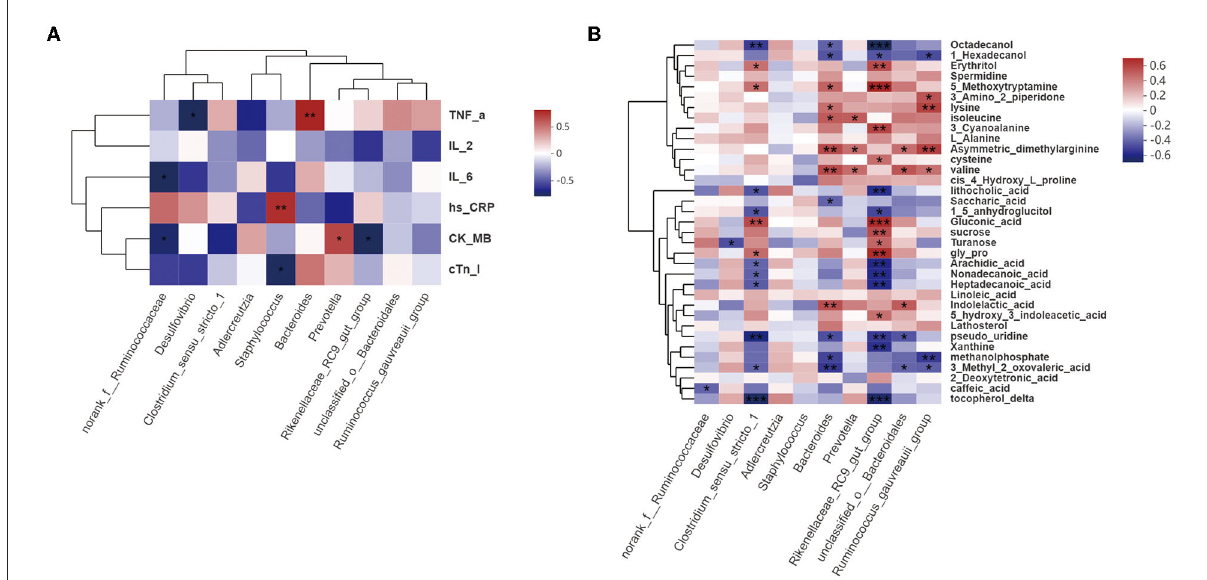
FIGURE8 Correlation analysis. (A) Correlations among gut bacteria, proinflammatory factors (TNF- α , IL-2, IL-6, and hs-CRP), and cardiac function indices (CK-MB and cTnI) (Spearman’s r > 0.1 or < 0.1; n = 6/group). (B) Correlations among gut bacteria and metabolites (Spearman’s r > 0.1 or < 0.1; n = 6/group). * P < 0.05, ** P < 0.01, *** P <